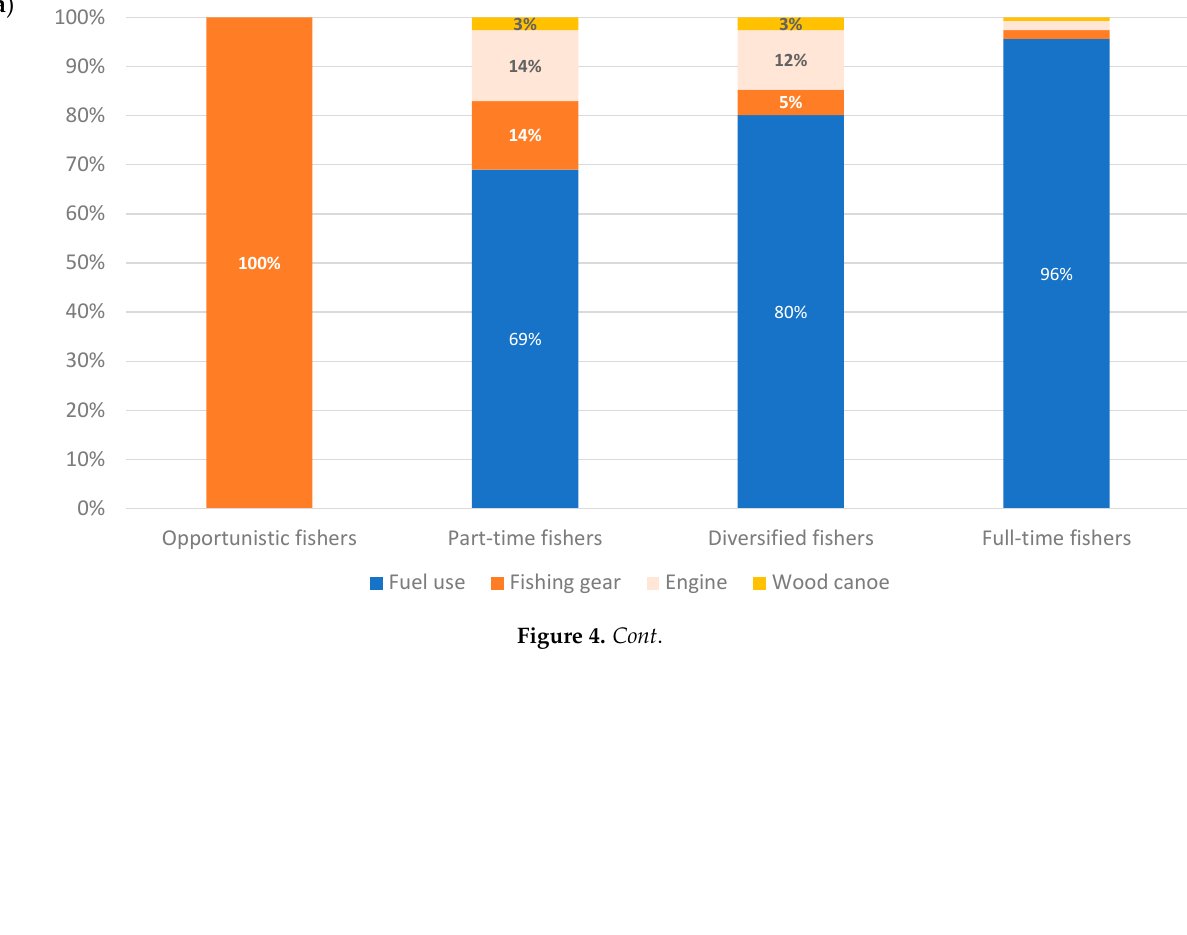
Figure 3. Contribution analysis of Gambian fish products per t of product and relative to the single scores of ( a ) fresh fish products and ( b ) processed fish